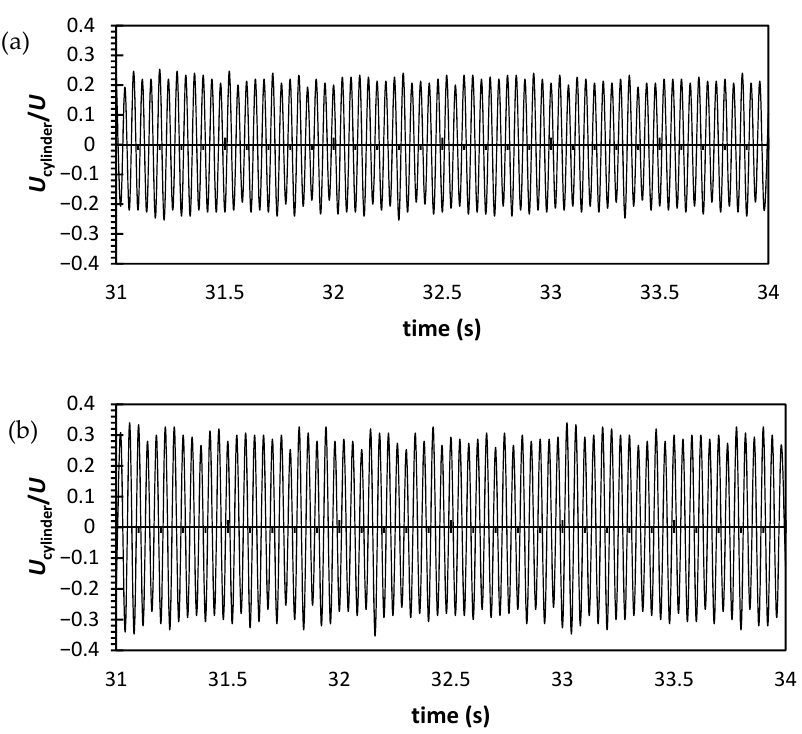
Figure 9. The normalized structural velocity of aluminum flexible cylinder at Re = 2500 in the y -direction ( a ) AR = 50; ( b ) AR = 54.